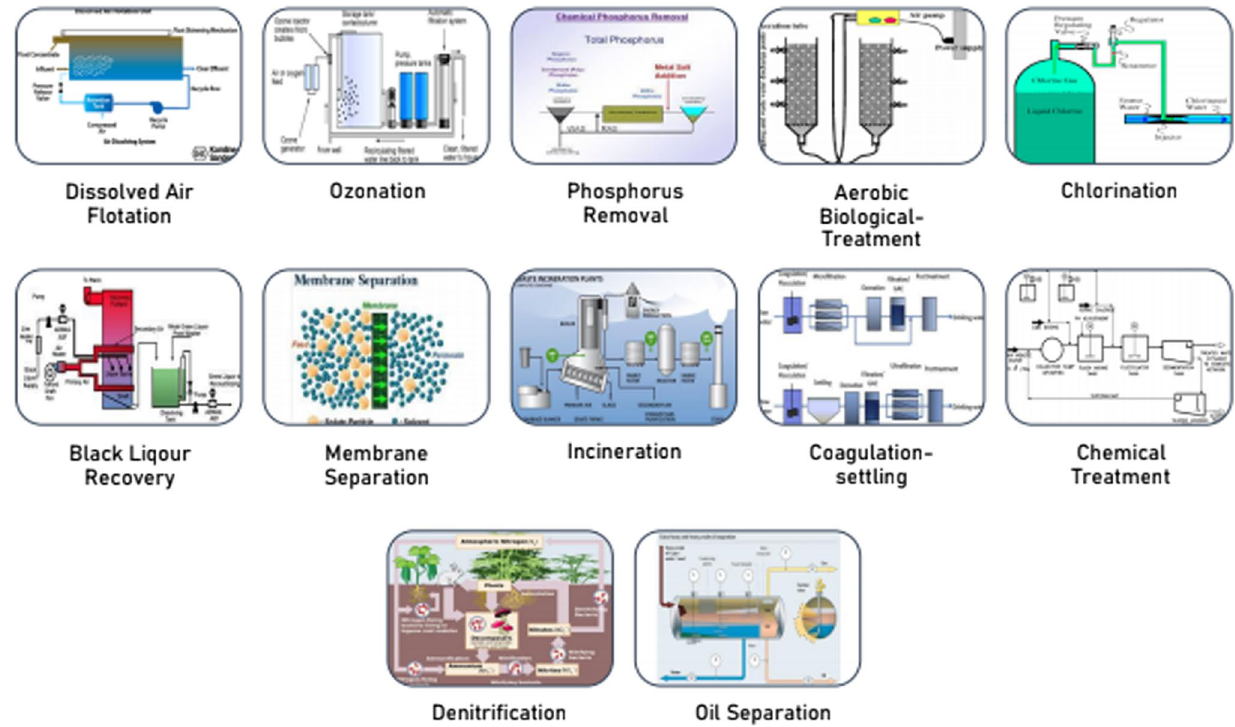
Fig. 4 Various treatment methods in food